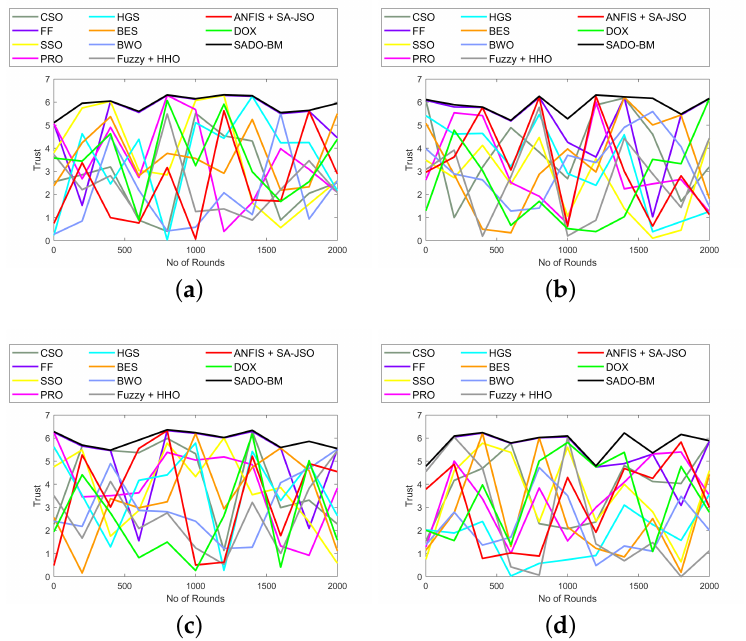
Figure 10. Trust analysis of SADO-BM over other models for node counts ( a ) 100, ( b ) 250 ( c ) 750, and ( d )